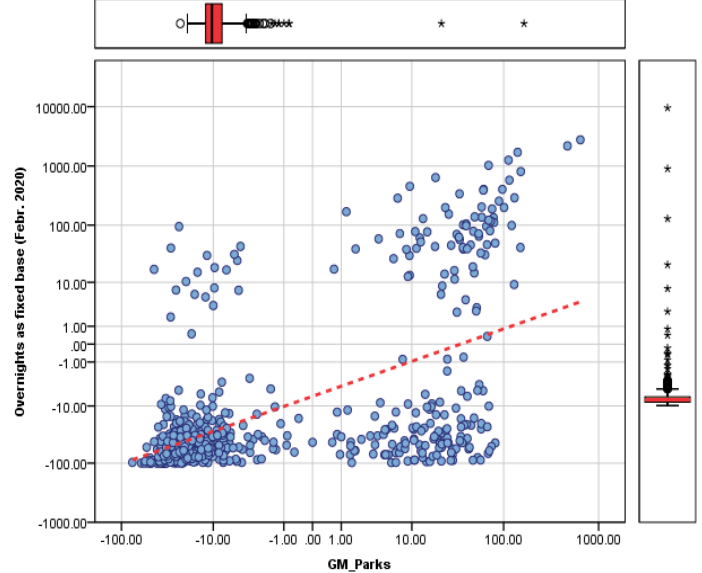
Figure 7. Overnight and GM Parks.